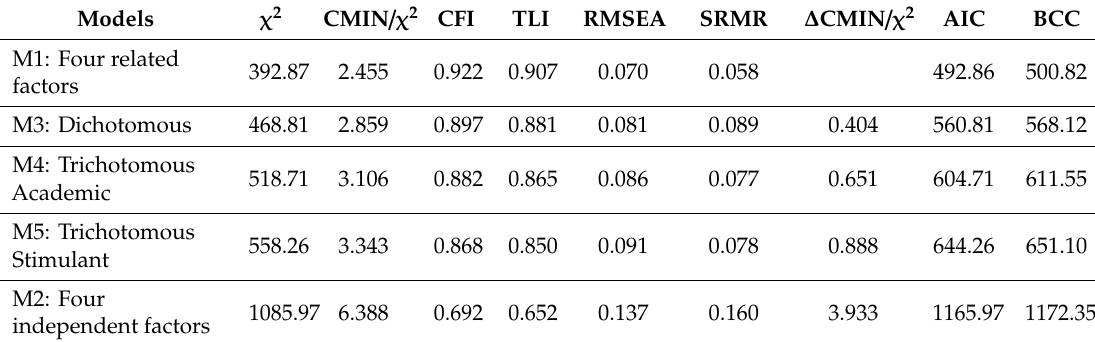
Table 2. Goodness of fit indices of the proposed models.